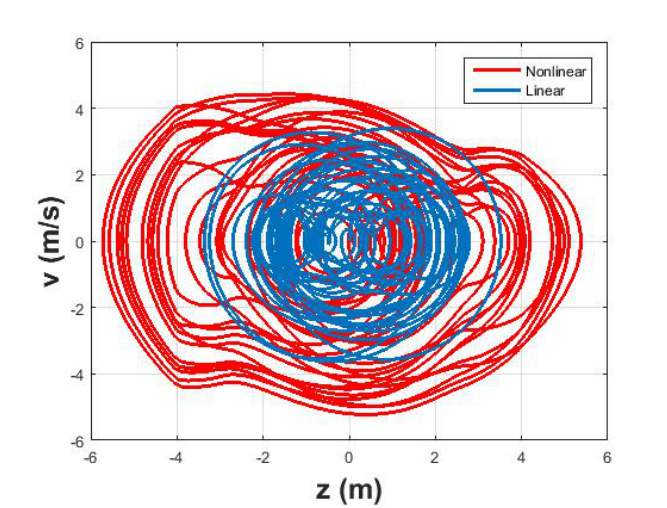
Figure 21. Comparison between the linear and nonlinear WECs in irregular waves: phase plot.